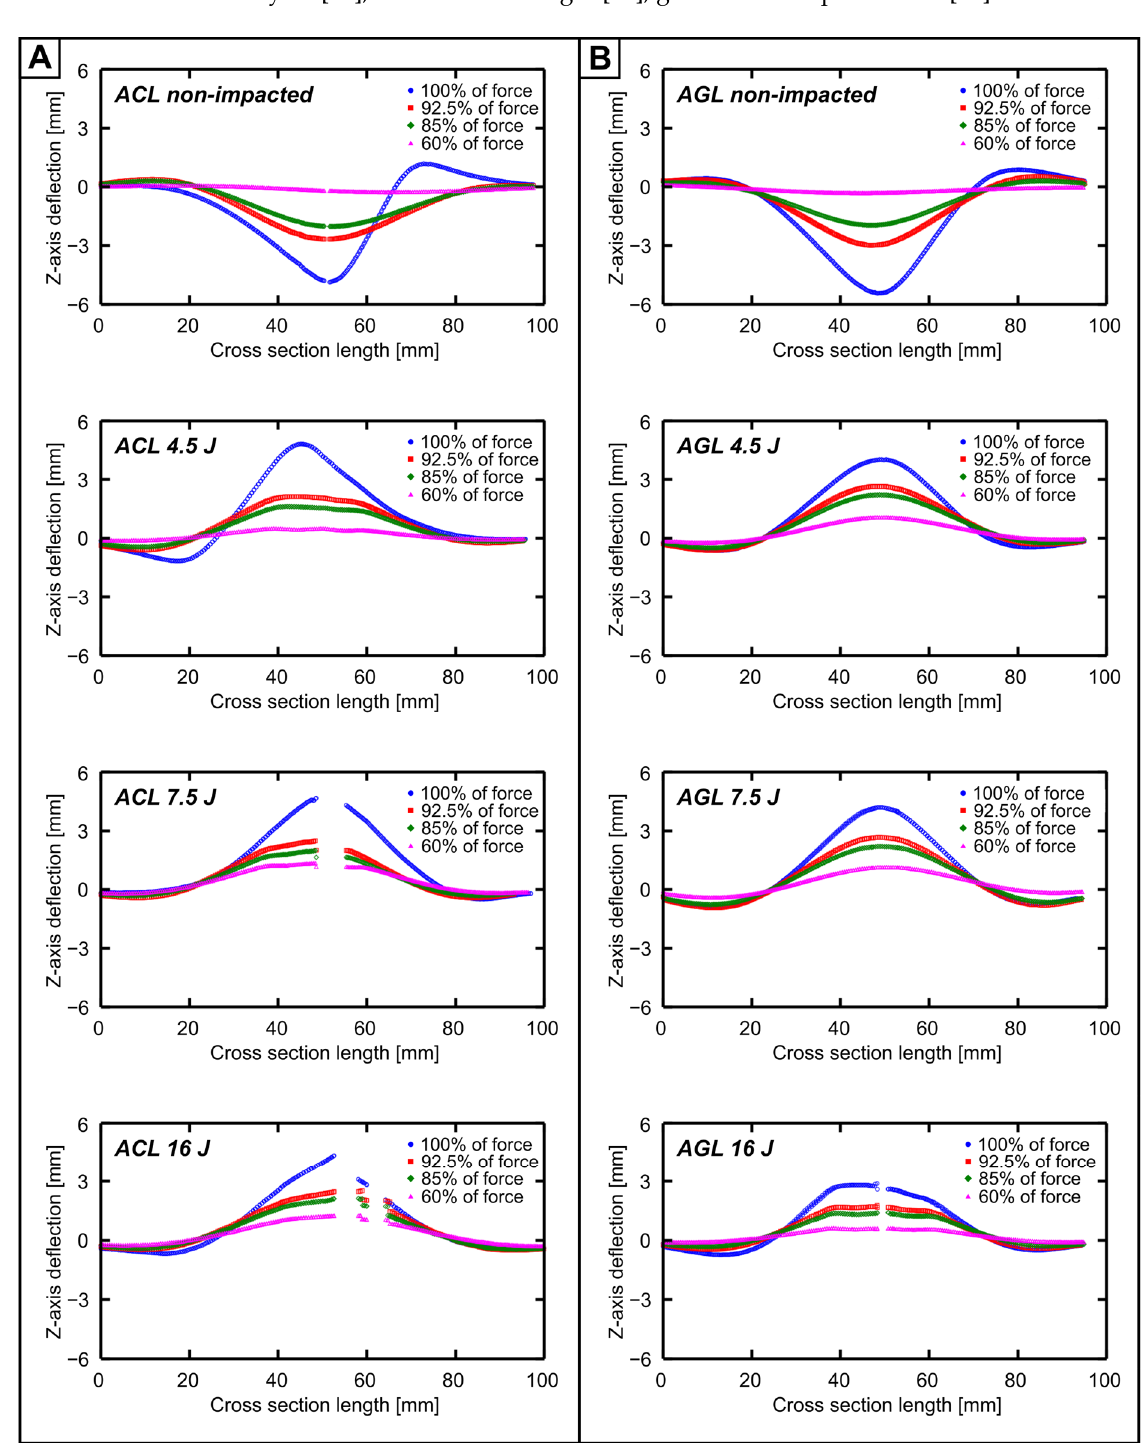
Figure 9. Comparison of displacement distribution on the plate cross section running through the impact point. Deformations for ACL ( A ) and AGL ( B ) were correlated with impact energy and used force threshold.